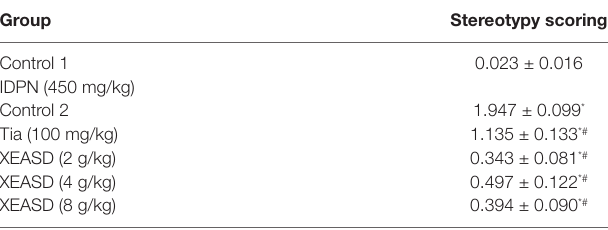
TABLE 2 | Effects of Tia and XEASD treatments on stereotypy scoring in IDPN- induced TS mice. Group Stereotypy scoring